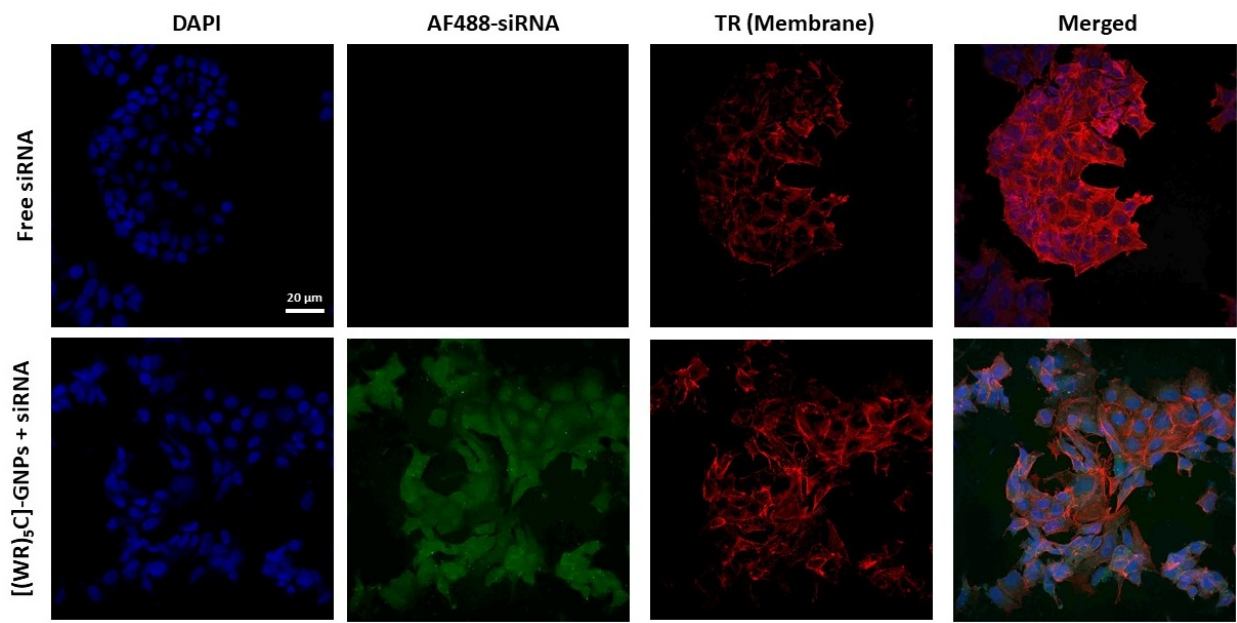
Figure 10. Confocal microscope images of Alexa 488-siRNA uptake by MDA-MB-231 cells in the presence of [(WR) 5 C]- GdNPs after 2 h incubation. AF488 represents Alexa fluor 488 and TR represents Texas Red.